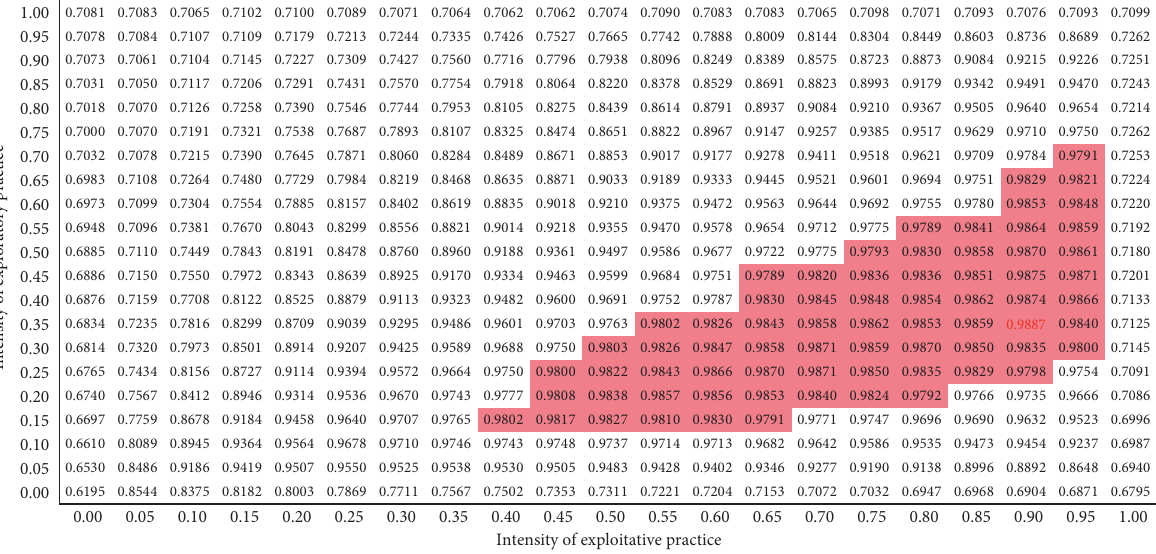
Figure 3: Effect of practice strategy on organizational